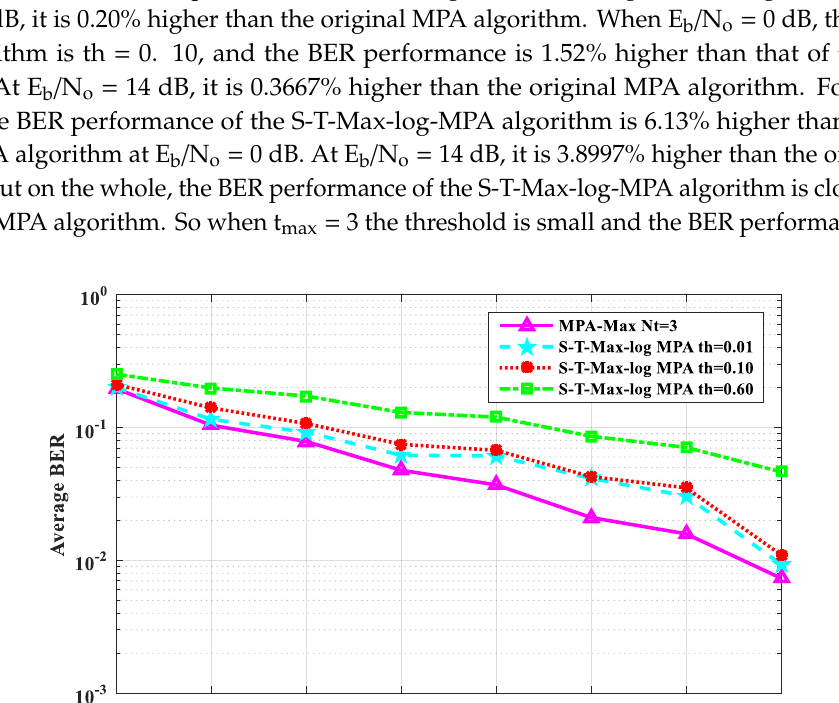
Figure 4. Comparison of average BER performance when t max = 3.